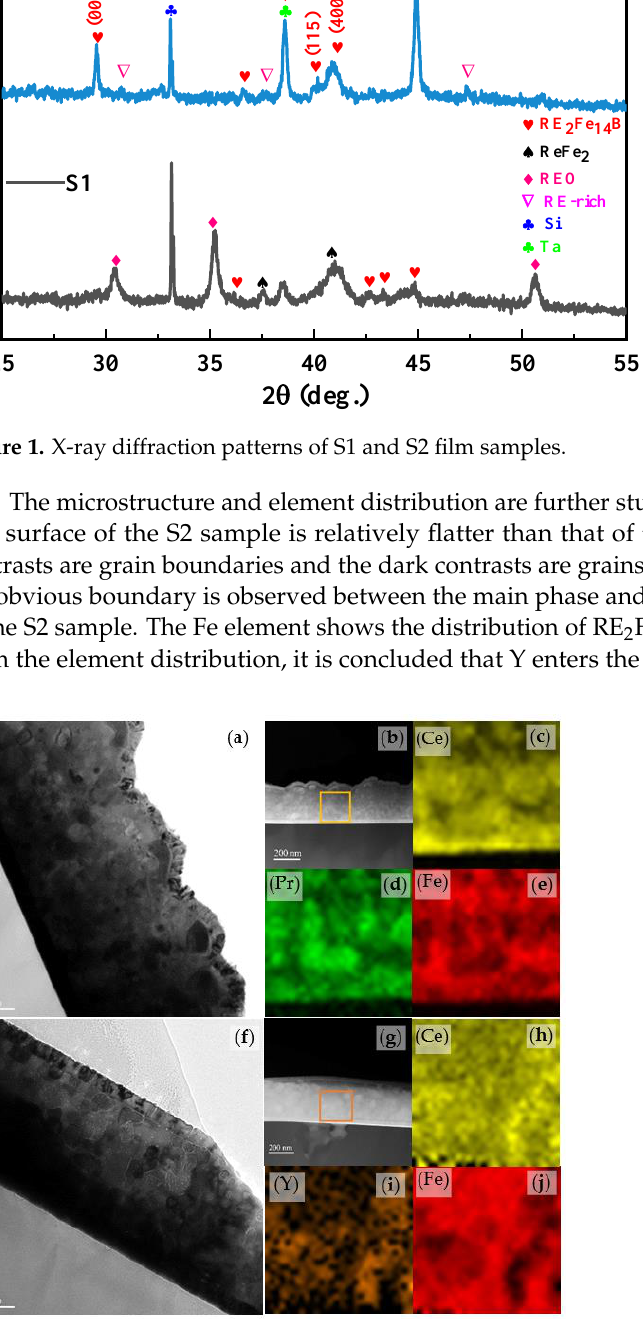
Figure 2. Cross-section bright-field TEM images of ( a ) S1 sample and ( f ) S2 sample; ( b , g ) are corre- sponding HADDF images of the S1 and S2 samples; the elemental concentration distribution map- pings of ( c ) Ce, ( d ) Pr, ( e ) Fe of selection region in ( b ); the elemental concentration distribution map- pings of ( h ) Ce, ( i ) Y, ( j ) Fe obtained from the selection square region in ( g ). The magnetic hysteresis loops and initial magnetization curves for both S1 and S2 samples measured at room temperature are given in Figures 3 and 4. As shown in Figure 3b, the S2 sample has better perpendicular magnetic anisotropy (PMA) by comparing the difference of out-of-plane (OOP) and in-plane (IP) loops. It is seen from Figure 3a,b that the coercivity increases from 0.63 T to 0.97 T in the OOP direction. The OOP is the c-aixs direction of films. It can be concluded that the S2 sample has a better c-axis orientation. Meanwhile, the PMA and the squareness of hysteresis loop are also enhanced. The im- provement of magnetic properties can be attributed to the following three aspects: an in- crease in the formation of the RE 2 Fe 14 B-type main phase with the enhanced c-axis orienta- tion, a decrease in the REFe 2 and REO phases, and a more orderly arrangement between hard magnetic main phase and other phases. Figure 4 shows the initial magnetization curves of the S1 and S2 samples. According to the shapes of initial magnetization curves, the coercivity mechanisms of the S1 and S2 samples belong to a mixture of nucleation and pinning mechanisms.